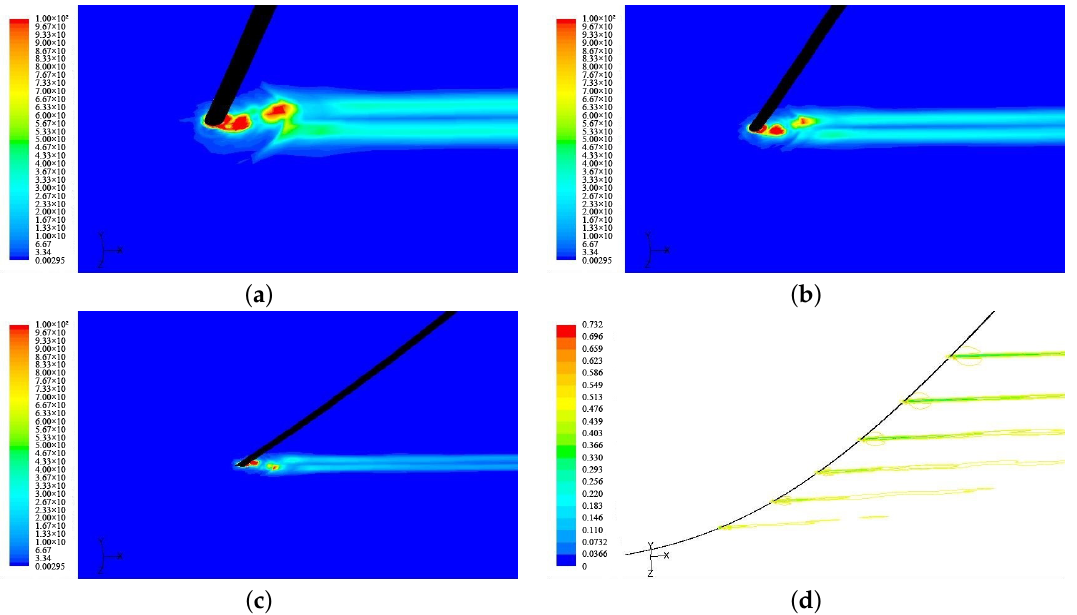
Figure 15. Cloud map of vorticity contour behind the SCR at different underwater depths: ( a ) cloud map of vorticity contour behind the SCR at 1 m underwater; ( b ) cloud map of vorticity contour behind the SCR at 2 m underwater; ( c ) cloud map of vorticity contour behind the SCR at 3 m underwater; ( d ) contour map of vorticity behind the SCR at different depths.